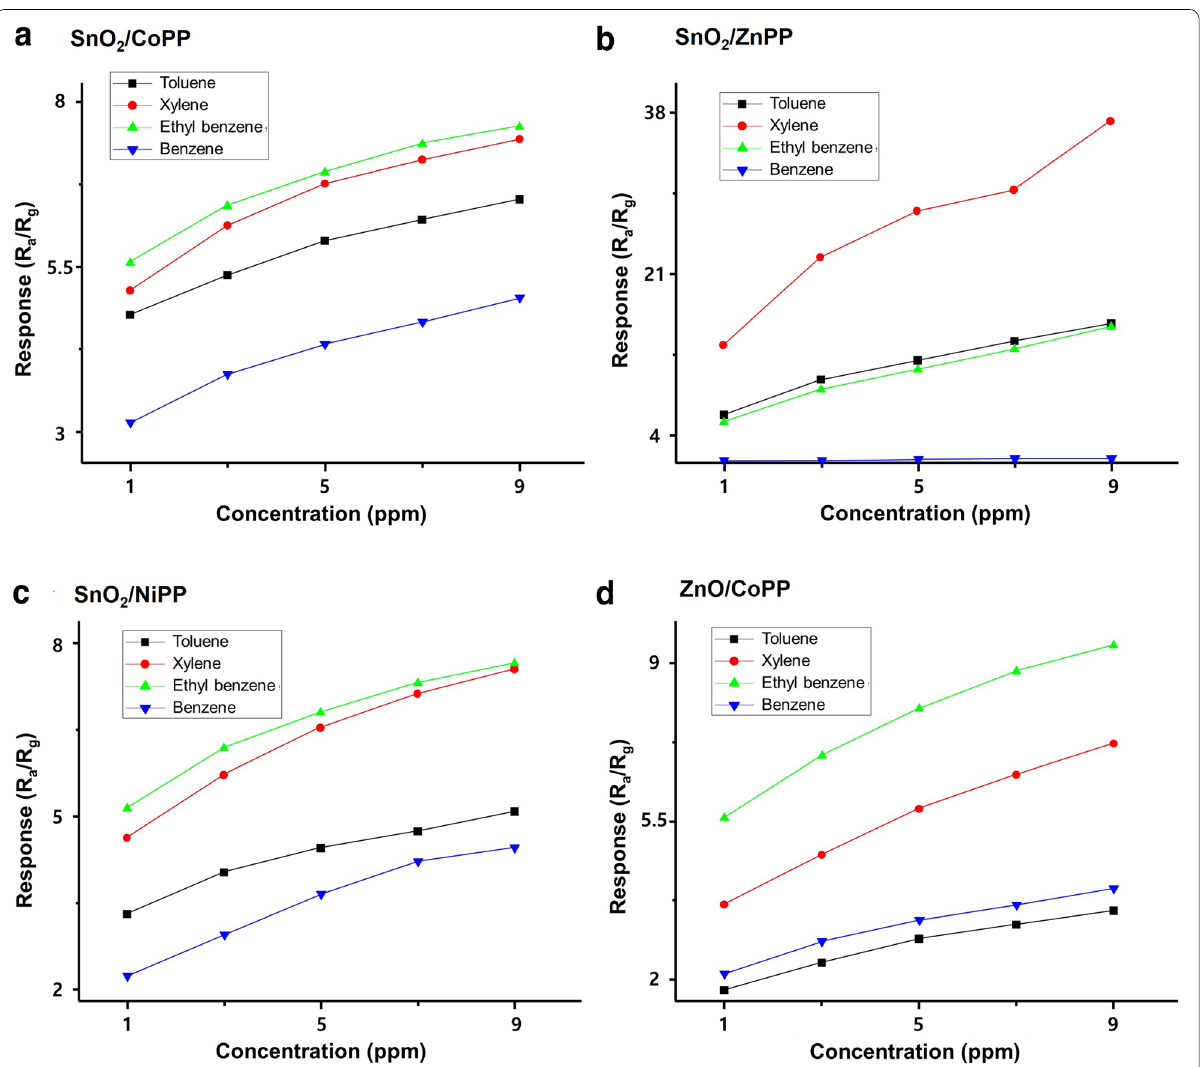
Fig. 5 Concentration-response graphs of the sensor array composed of 4 MOX NP/MPP-based sensors for BTEX. a SnO 2 /CoPP, b SnO 2 /ZnPP, c SnO 2 / NiPP, and d